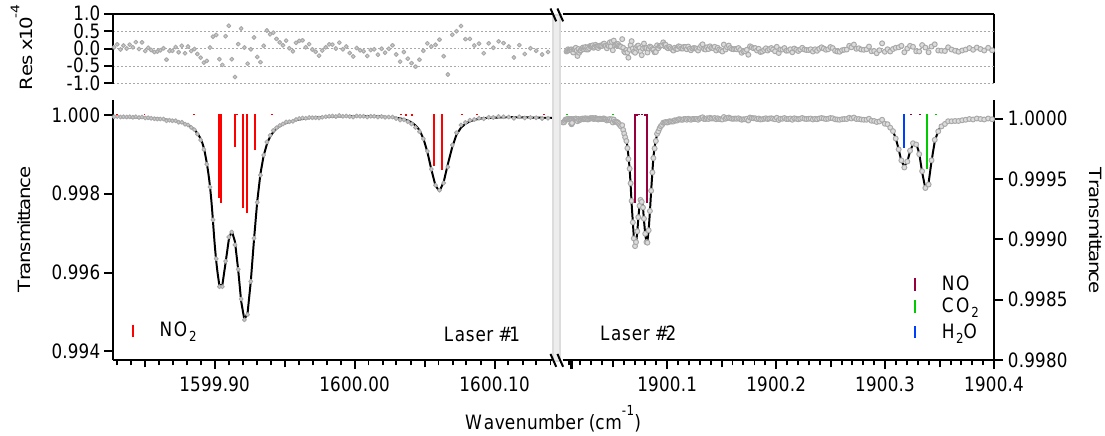
Fig. 1. The selected spectral windows with the absorption lines of NO and NO 2 as measured in ambient air with the dual-laser spectrometer with a multi-pass cell of 204m path-length at 50hPa sample pressure. The gray circles indicate measurement points, while the black line is a least-square fit to the data. The residual is shown in the top panel. The colored sticks indicate individual absorption lines of molecules that absorb within the scanning range of the